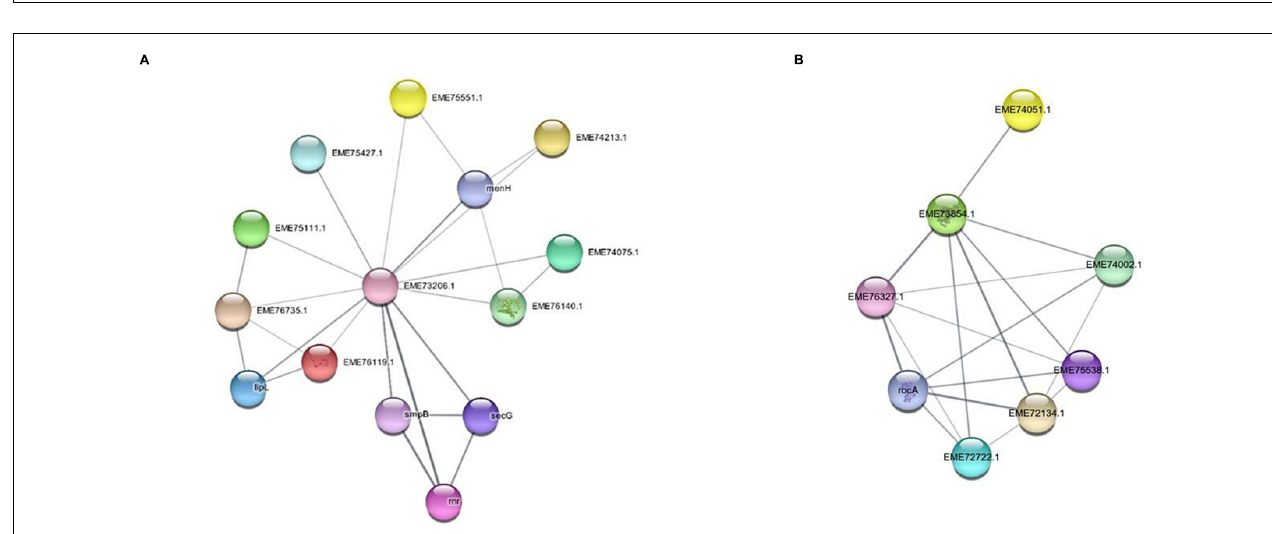
FIGURE 11 | Network analysis of (A) carboxylesterase and (B) aldehyde dehydrogenase gene. String interaction network displaying the relationship of gene clustered in a module.